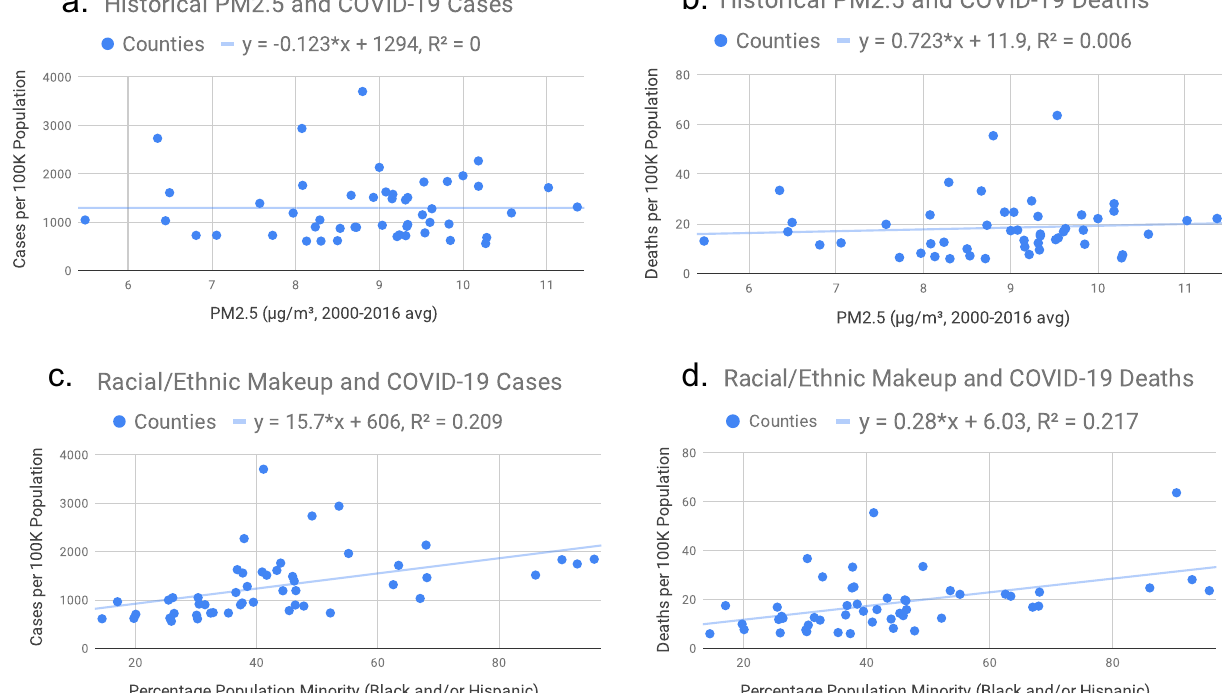
Figure 1. (Fig. 1 a –1 d ) Correlation between race/ethnic minority, PM 2.5 , and COVID-19 for the 50 Most Populous Counties in Texas. ( a ) Historical PM2.5 and COVID-19 cases. ( b ) Historical PM2.5 and COVID-19 deaths. ( c ) Racial/ethnic makeup and COVID-19 cases. ( d ) racial/ethnic makeup and COVID-19 deaths.